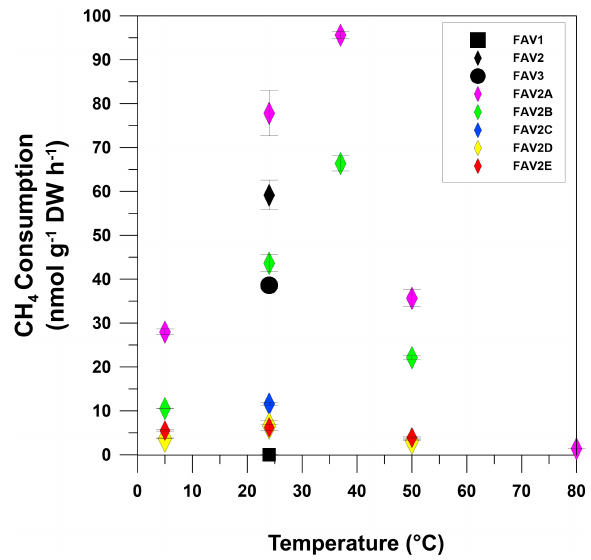
Figure 2. Methane consumption of soils sampled at sites FAV1, FAV2 and FAV3 (after incubation at controlled room temperature), and at different depths of FAV2 (soils incubated at different temper-